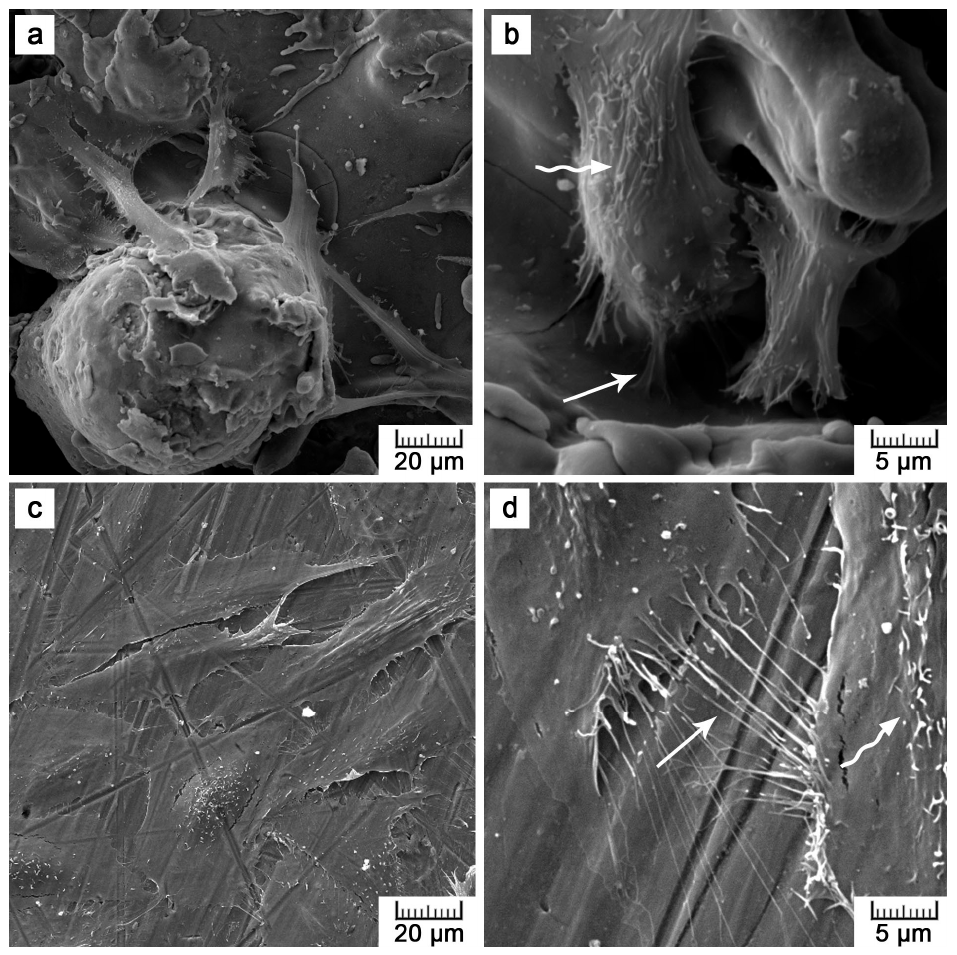
Figure 11. Images of Saos-2 cells cultivated on: ( a , b ) the plasma-sprayed titanium and ( c , d ) ground control for four days obtained by scanning electron microscopy (arrow—filopodia, wavy arrow—microvilli).